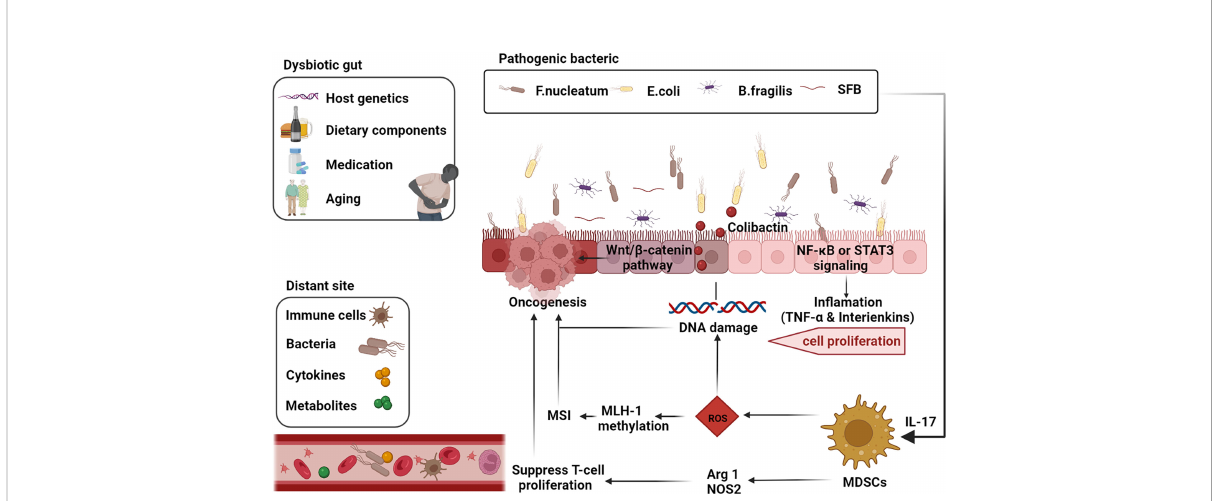
FIGURE 1 Gut-microbiome-mediated mechanisms of oncogenesis and progression. Factors such as the host genetics, unhealthy dietary components, medication, and aging cause gut dysbiosis. In fl ammatory markers such as TNF- a and interleukins such as IL-17 are activated by the corresponding pathogenic microbial strains via the NF- k B or STAT3 pathways thereby inducing cell proliferation. Microbial strains such as Segmented fi lamentous bacteria (SFB) are effective inducers of Th17 cells in the SILP. E. coli induces DNA damage and thus promotes tumorigenesis through the release of virulent substances such as coliphage. Clostridium nucleatum activates the differentiation of myeloid- derived suppressor cells (MDSCs) and further induces reactive oxygen species (ROS), leading to MutL homolog 1 (MLH-1) methylation and microsatellite instability (MSI), leading to tumor progression. Activated MDSCs also inhibit T cell differentiation and promote tumor progression through activation of Arg1 and NOS2-mediated antitumor immunity (adapted from 16). F, nucleatum also stimulates cell proliferation through activation of the Wnt/ b -linked protein pathway. Many components of our daily diet are metabolized by bacteria in the digestive tract and produce the corresponding metabolites such as secondary bile acids, which promote carcinogenesis. Furthermore, intestinal microbiota, microbial metabolites, immune cells and cytokines can also produce carcinogenic effects at different sites in the distal part of the body through blood circulation. (The fi gure was created with